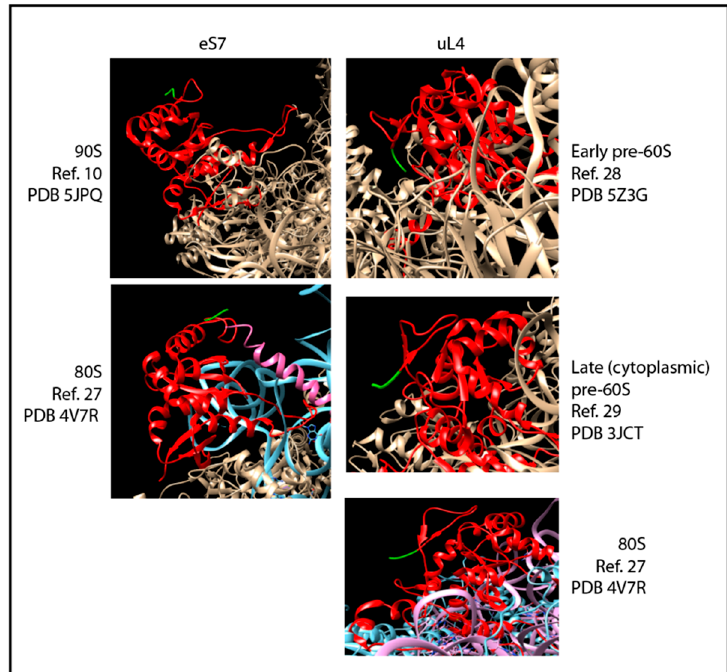
Figure 4. Structure models of the N-terminal ends of eS7 and uL4 in precursor and mature ribosomes. In the left-hand column eS7 is in red with the three N-terminal amino acids in green. Ribosomal protein eL19 in the 80S model is in pink. In the right-hand column uL4 is in red with the three N-terminal amino acids in green. References and PDB IDs for each model are indicated by each panel.